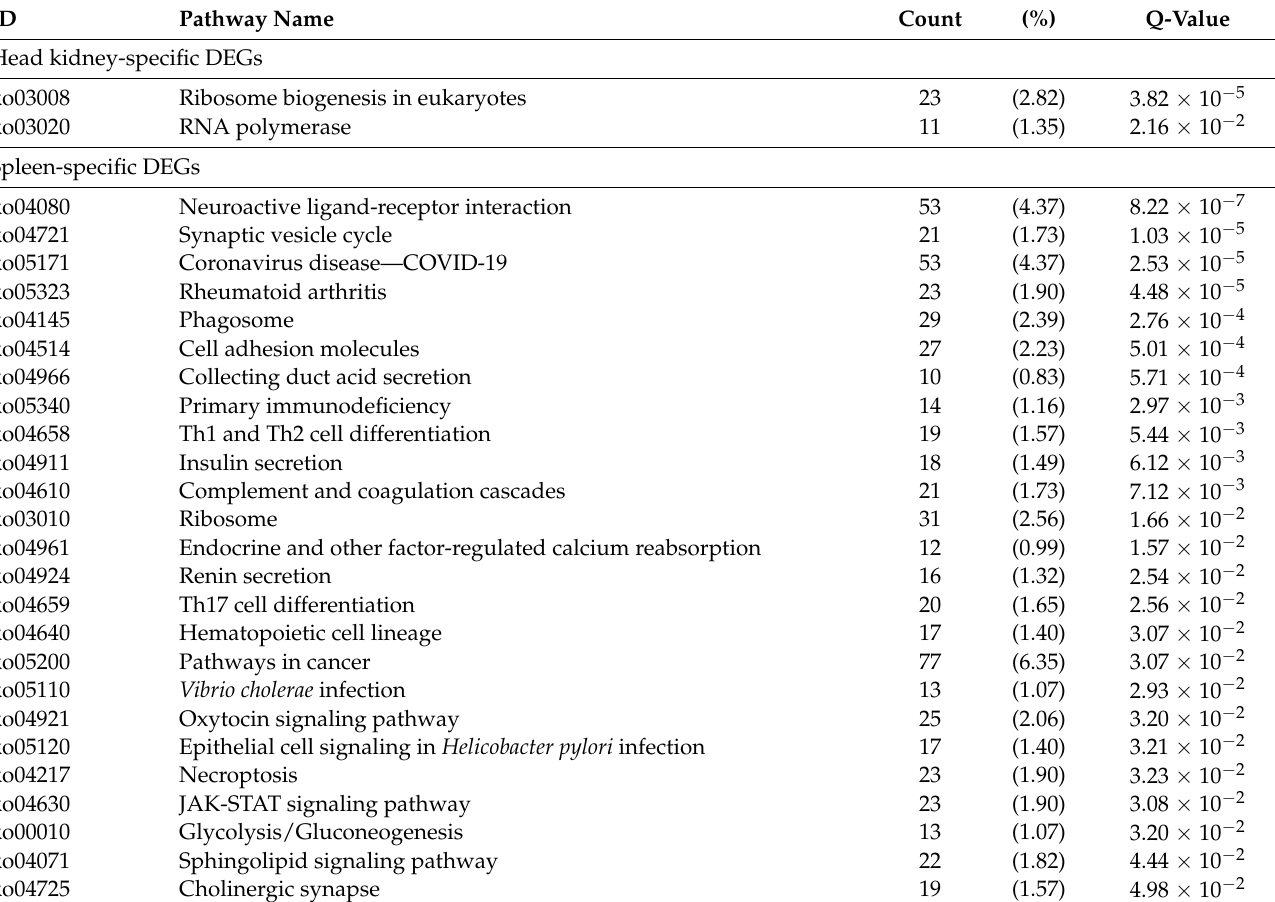
Table 1. Functional enrichment analysis results of KEGG pathways for specific and common differentially expressed genes (DEGs) in the head kidney and spleen.